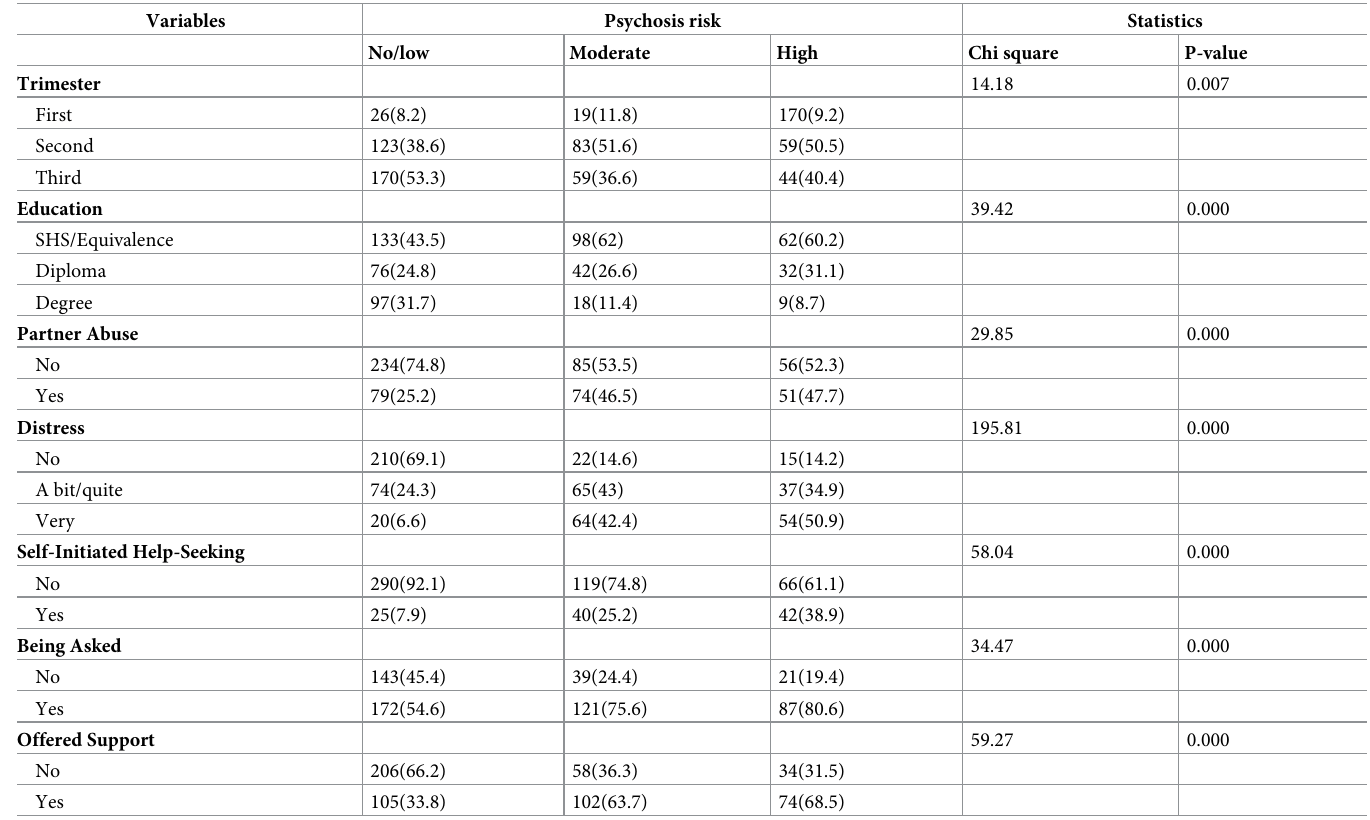
Table 1. Chi square results of the correlation between psychosis risk group and categorical